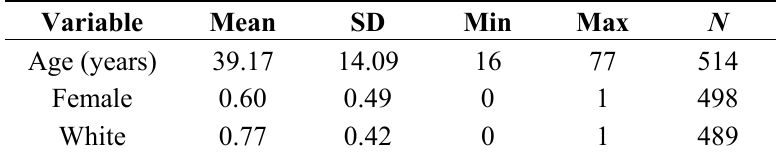
Table 2. Descriptive statistics of study participant pool.